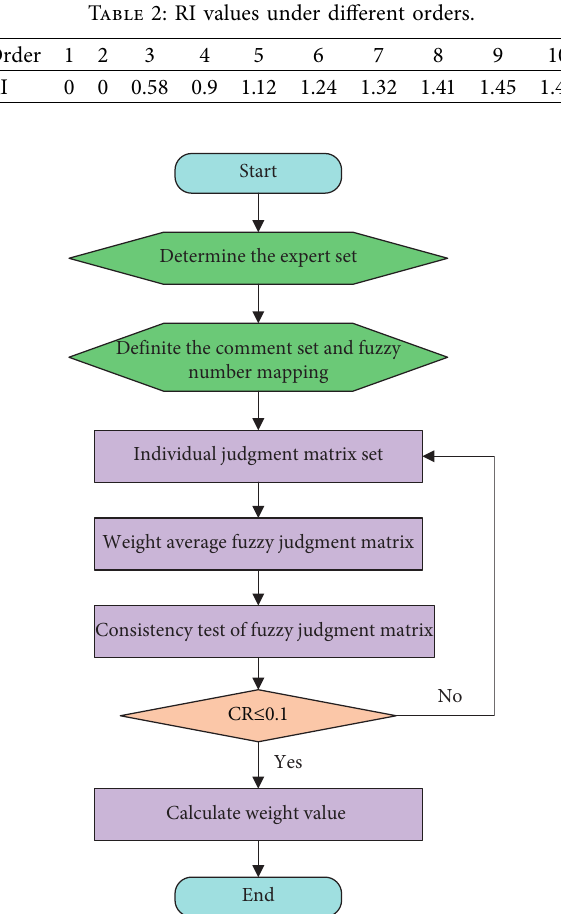
Figure 2: General idea of GFAHP